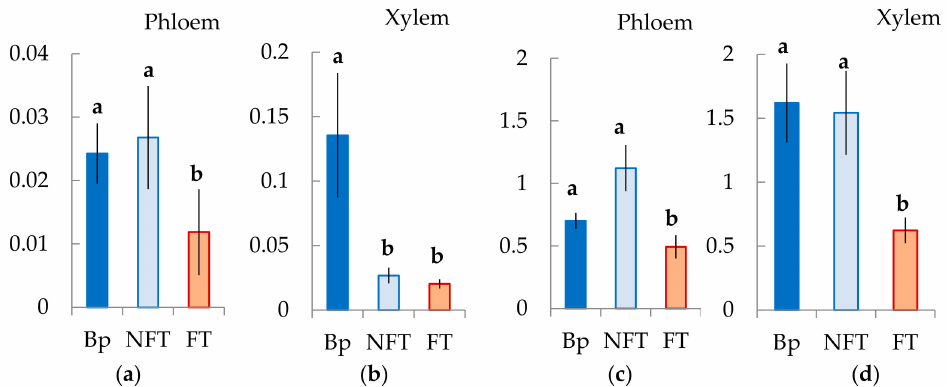
Figure 13. Relative expression (arbitrary units) of genes BpARF5 ( a , b ) and BpHB8 ( c , d ) in tissues including the cambial zone, the differentiating phloem and the mature phloem (Phloem), and the differentiating xylem (Xylem) B . pendula var. pendula (Bp), non-figured (NFT) and figured (FT) B . pendula var. carelica trees. Samples were collected on 26 June 2020. Different letters indicate significant differences at p -value < 0.05. Bars are means of n experimental runs ± SD according to Mann–Whitney U-test. n = 9.